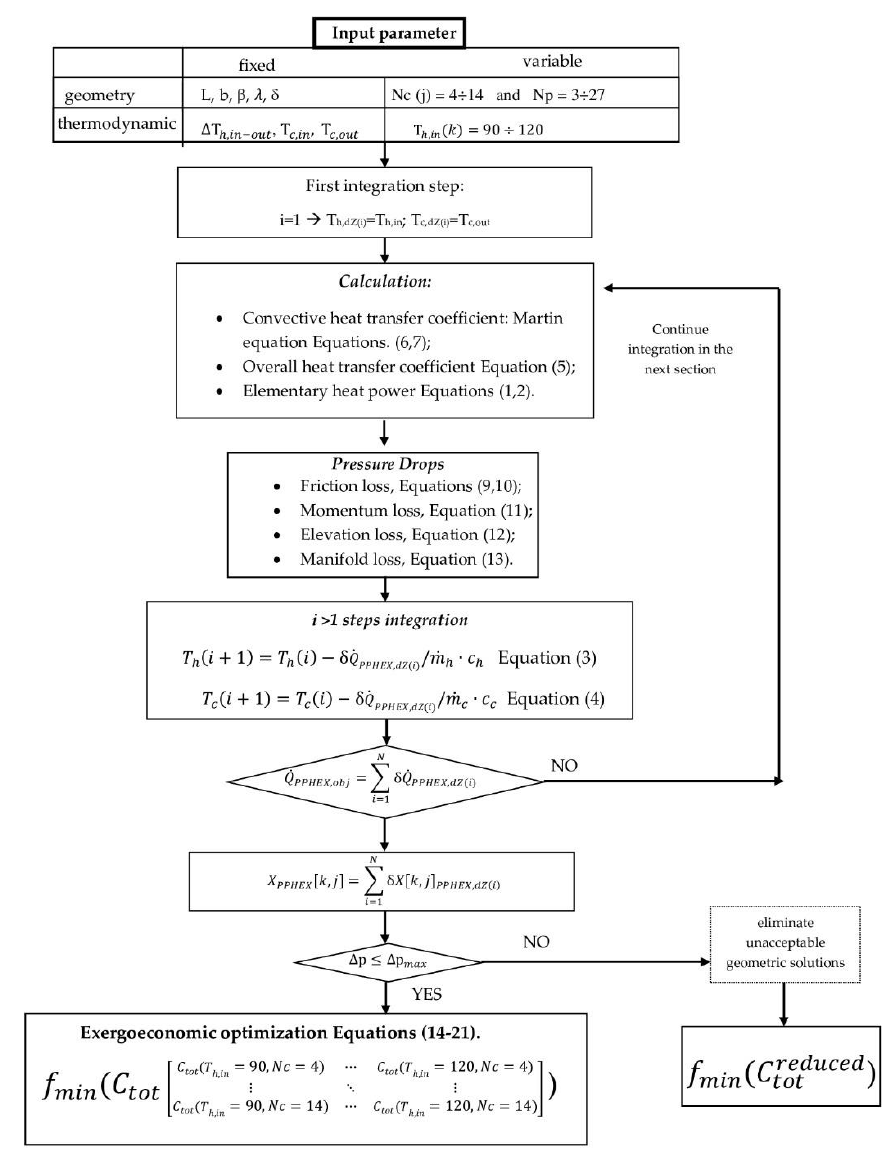
Figure 3. Algorithm flow